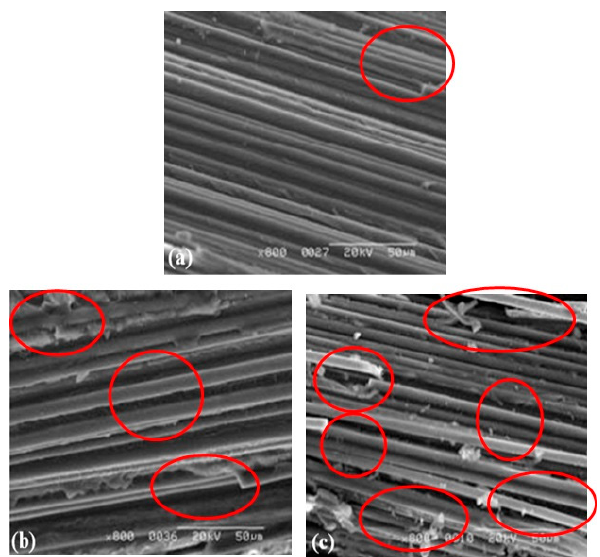
Figure 10. Observation of SEM micrographs of microstructural evolution in specimen ( a ) without thermal fatigue; ( b ) 1000 cycles thermal fatigue and ( c ) 2000 cycles thermal fatigue.